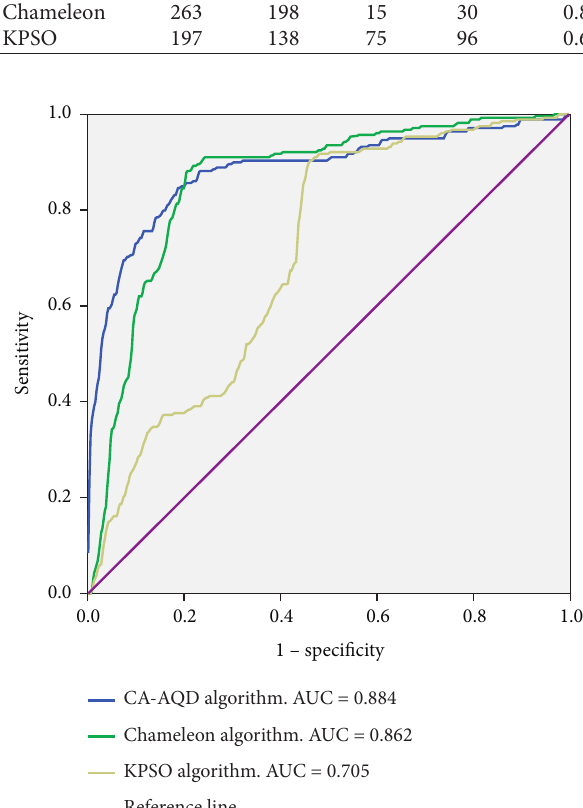
Figure 10: ROC for CA-AQD, Chameleon, and KPSO models.